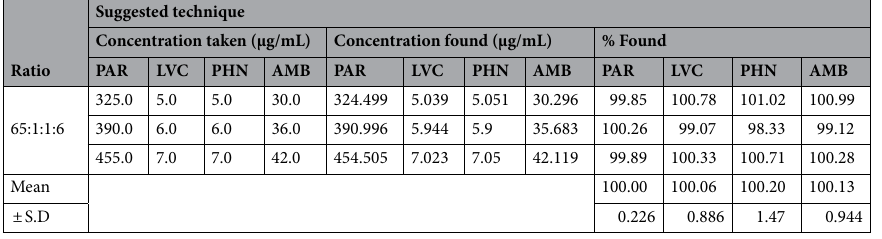
Table 8. Assay results for the determination of the studied drugs in synthetic mixtures of their pharmaceutical ratio (65:1:1:6) by the suggested HPLC technique .